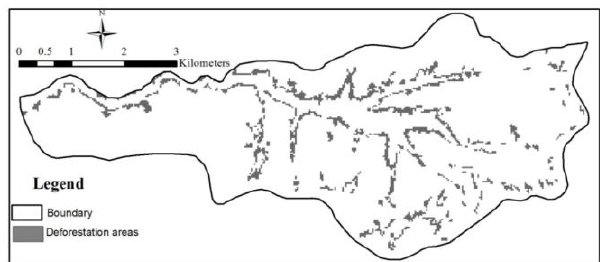
Figure 3. Deforestation map during